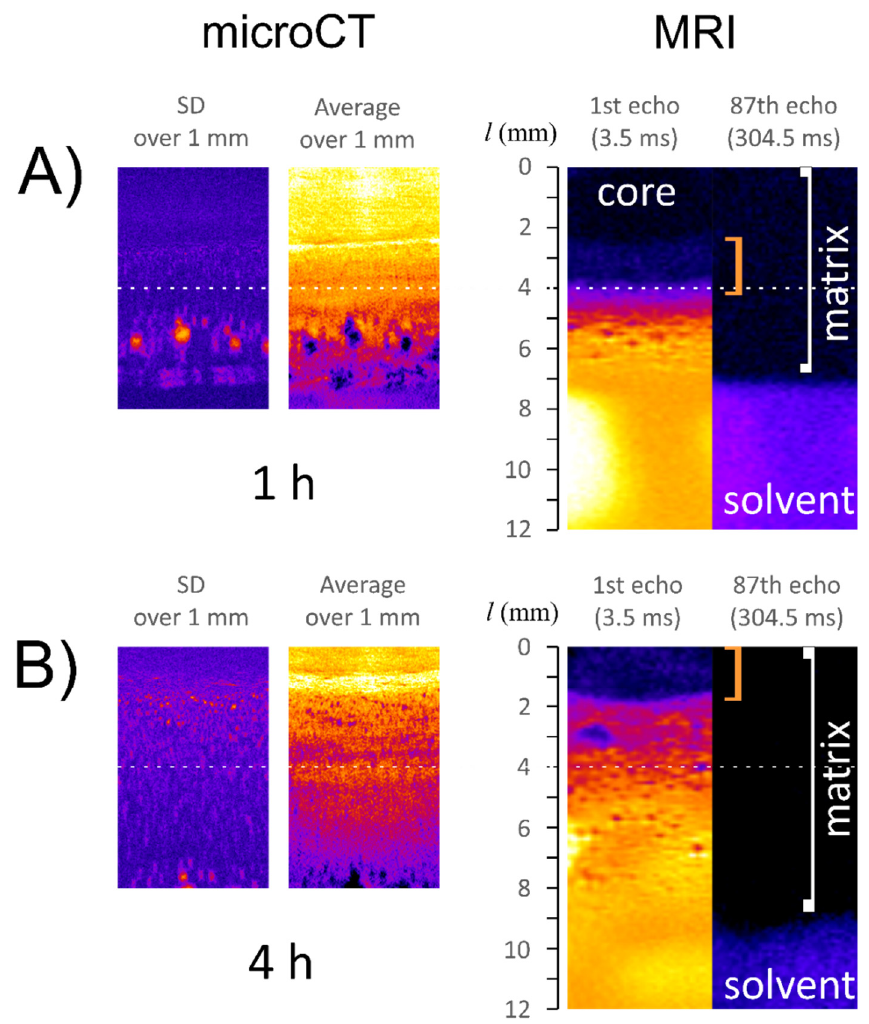
Figure 5. MicroCT (left) and MR images (right) of the profiles of ALG/SNA matrix at 1 h ( A ) and 4 h ( B ) of hydration: microCT image containing standard deviations of pixel intensity and image of averaged pixel intensity over all slices in 1 mm thick segment; MR images of the same fragment of ALG/SNA matrix at two echo times (3.5 and 304.5 ms)—orange square bracket marks region denoted as swollen-glassy as introduced by Ju et al. [41]. White dashed line marks initial end-position of the dry matrix before hydration.